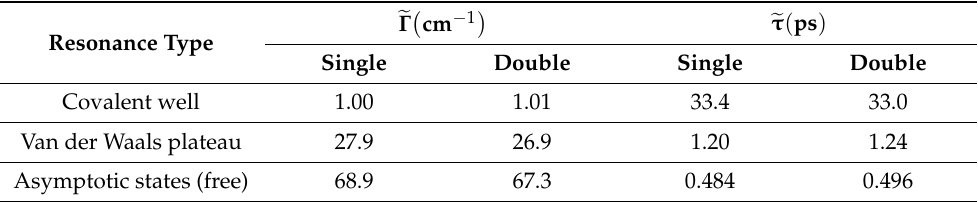
Table 2. Average resonance widths and their corresponding lifetimes for the states of three types in the singly and doubly substituted ozone molecules.